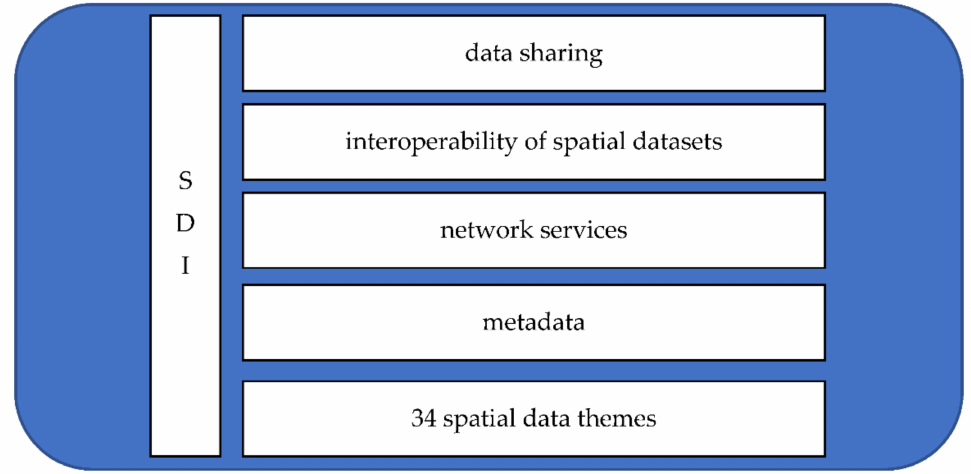
Figure 1. Spatial data infrastructure (SDI) features. Source: